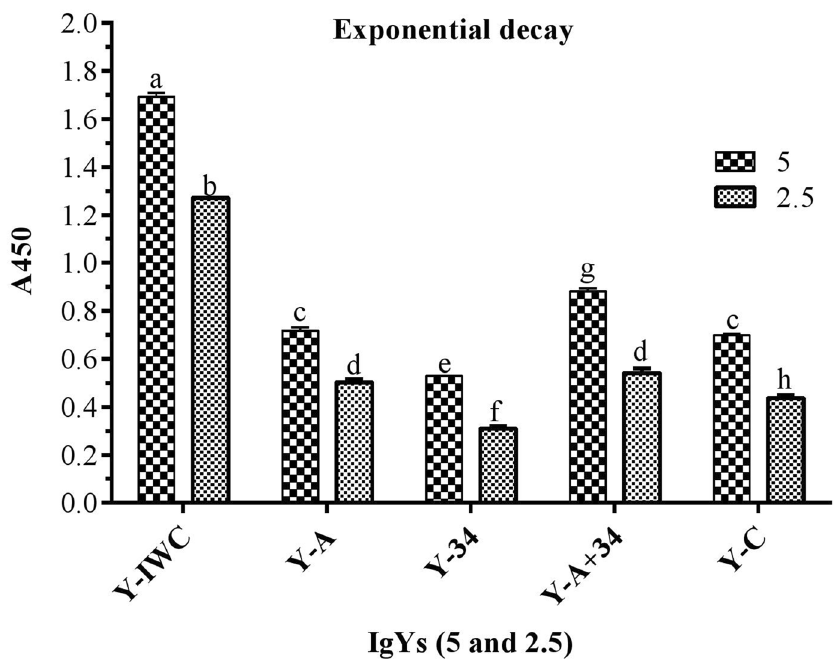
Figure 1. Whole cell ELISA with various IgYs. A. baumannii ATCC 19606 was coated as an antigen (3.6 × 10 7 CFU/well); 5 µg and 2.5 µg of each IgY was added to the wells. Y-IWC: IgYs raised against inactivated whole cell, Y-A: IgYs raised against rOmpA, Y-34: IgYs raised against rOmp34, Y-A + 34: IgYs raised against combination of rOmpA and rOmp34; and Y-C: control IgY. Mean values ± S.E are from independent groups and values superscripted by different letters are significantly different by Duncan’s multiple range tests ( P ≤